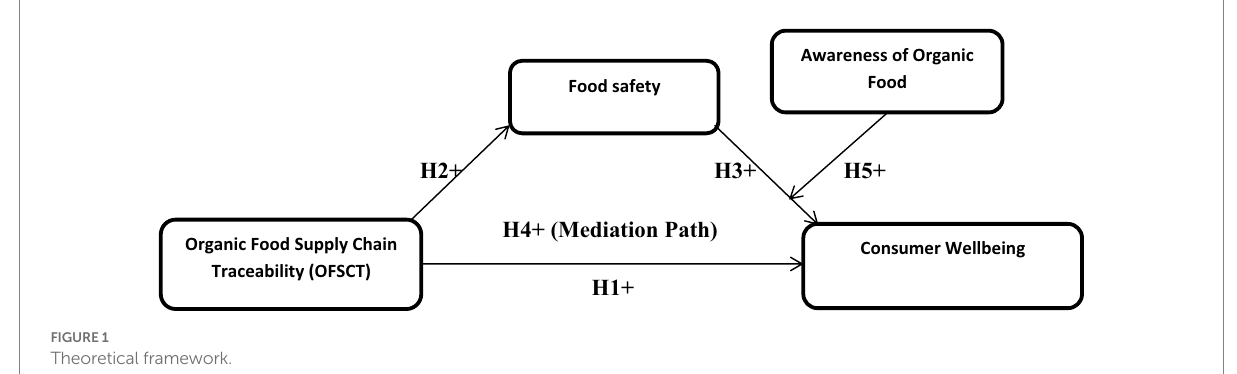
FIGURE 1 Theoretical